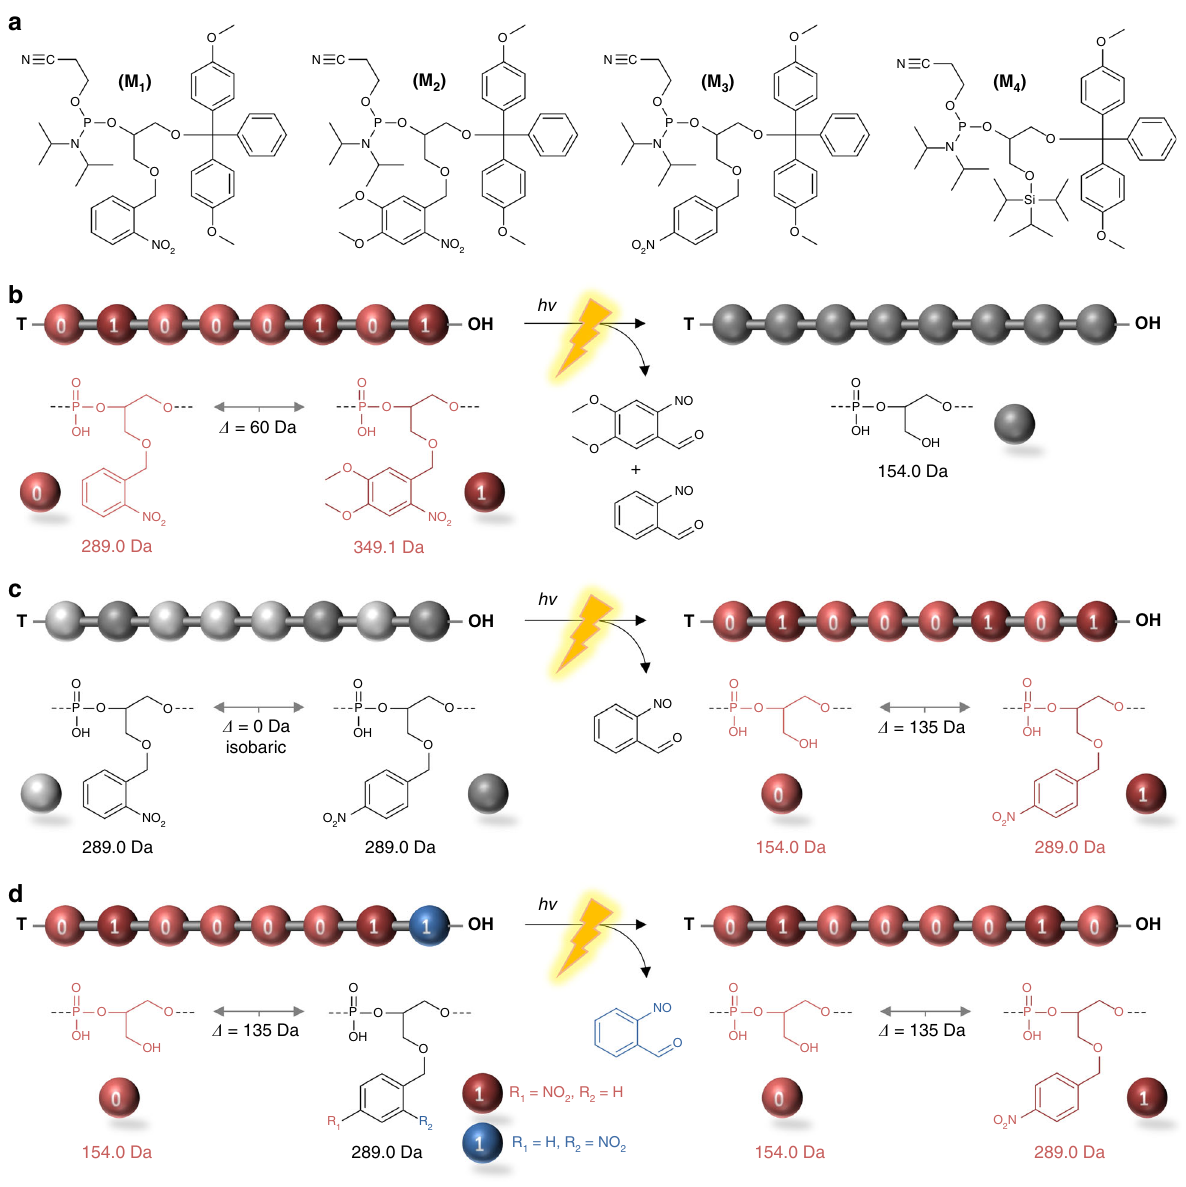
Fig. 1 Monomer and polymer design. a Molecular structures of the different phosphoramidite monomers that were synthesized and used in the present work. b Strategy for the preparation of photo-erasable digital polymers. In this case, monomers M1 and M2 are used as 0- and 1-bits, respectively. These monomers have different molar mass and therefore allow construction of digital sequences that can be decoded by MS/MS. Upon light irradiation, both 0 and 1 units are photo-cleaved, thus leading to a non-decodable homopolymer (depicted in gray). c Strategy for the preparation of polymers containing hidden messages. In this case, isobaric monomers M1 and M3 are used as an invisible binary ink, which lead to MS/MS non-decodable sequences. Light is then used as a revealer. Photo-irradiation cleaves selectively ortho -nitrobenzyl units, thus leading to a MS/MS decodable binary sequence. d Strategy for photo-induced site-directed mutations. In this case, the polymers are constructed using monomers M1 , M3 , and M4 . After TIPS deprotection, the formed digital polymer contains isobaric 1-bits (depicted in red and blue). Light irradiation allows selective 1 → 0 mutation of a single type of 1 unit (i.e. only the blue one). The letter T symbolizes a terminal thymidine nucleoside unit in panels b , c , and Digital polymers containing photo-revealable sequences . Monomers M1 and M3 were then used to build oligomers con- taining light-revealable information sequences (Supplementary Table 2). In order to con fi rm that polymers containing p -nitro-